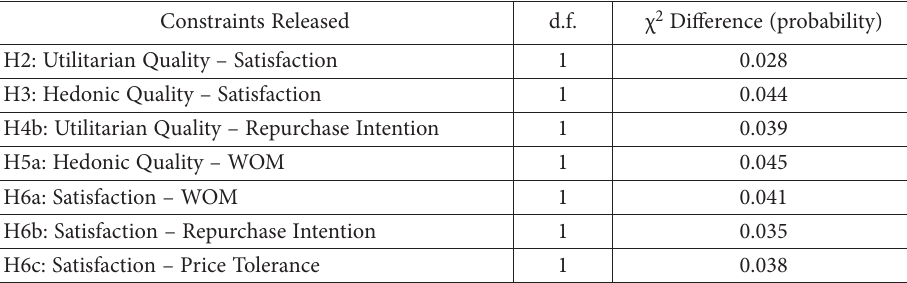
Table 7. Differences between groups of customers: testing